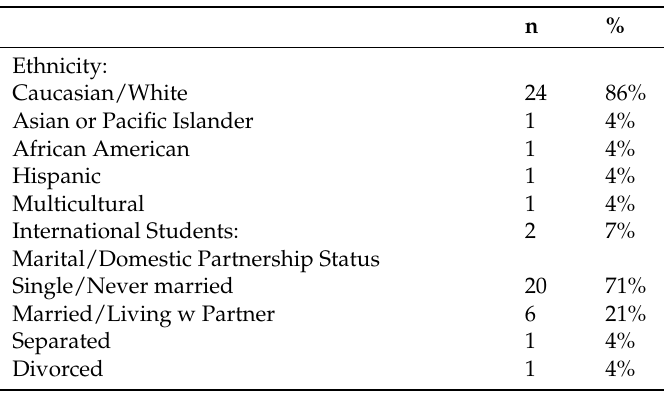
Table 1. Participant